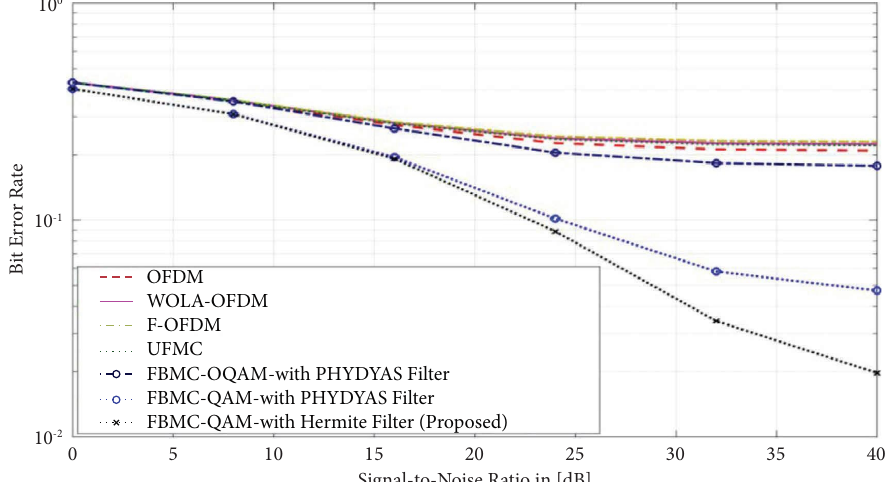
Figure 14: Bit error rate performance of diferent multicarrier modulation techniques for Vehicular B channel model at 1024 QAM.